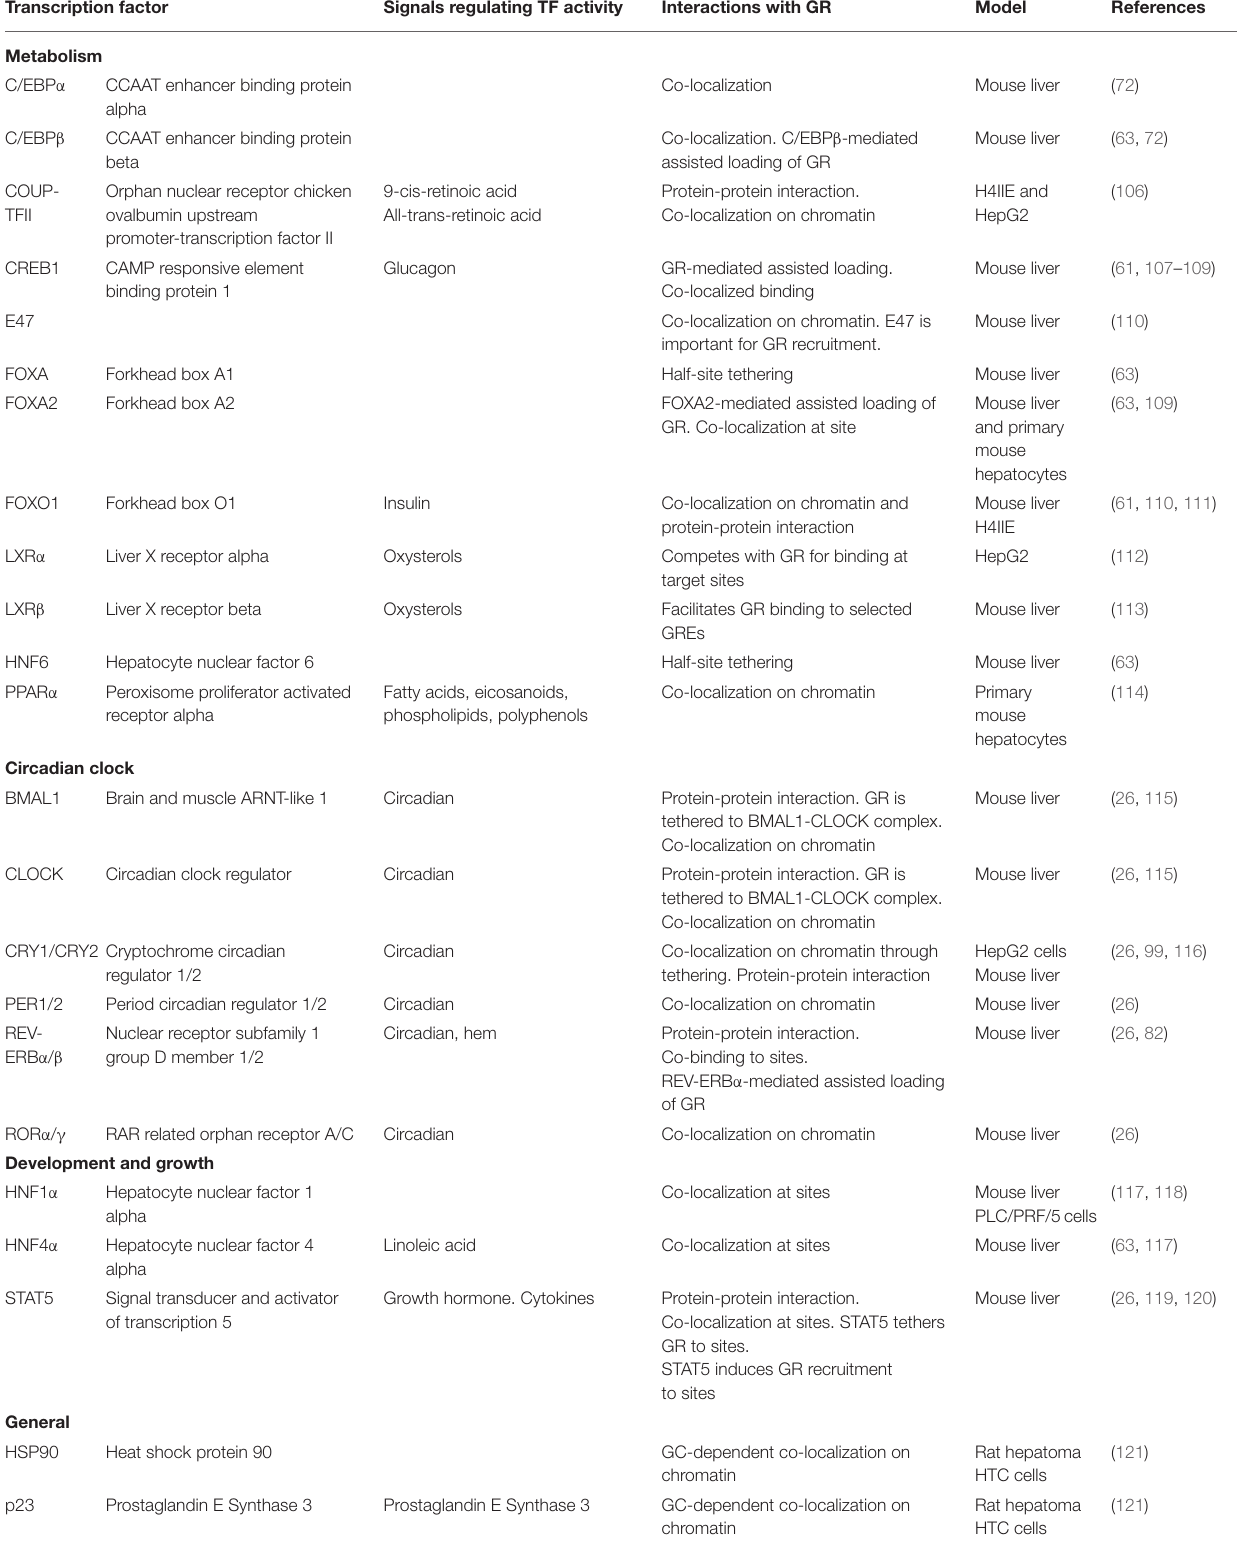
TABLE 1 | Examples of hepatocyte expressed transcription factors interacting with GR on